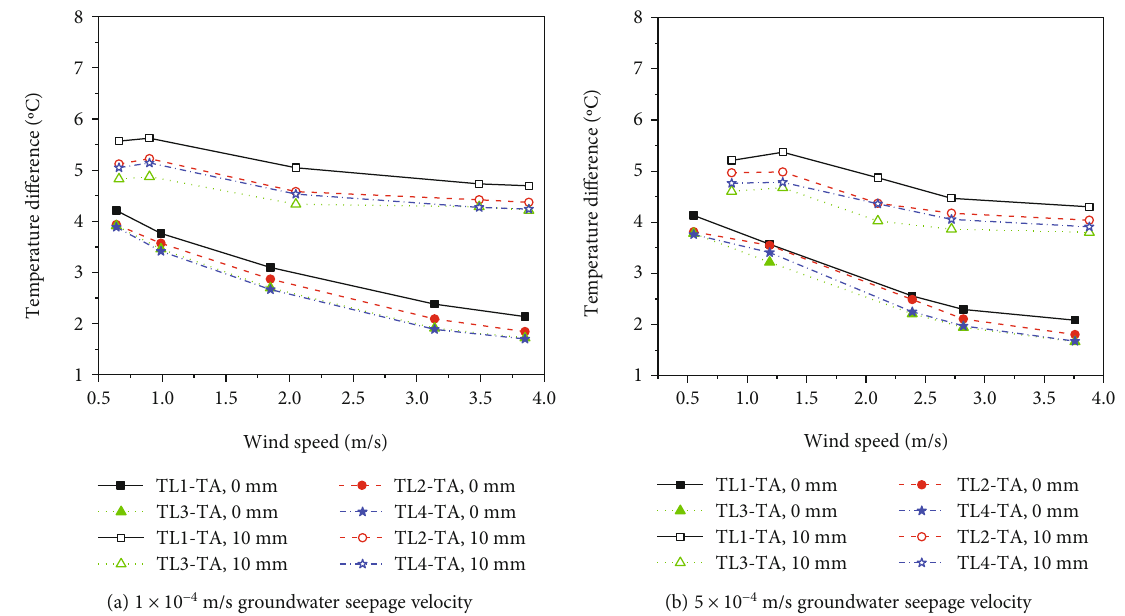
Figure 6: Impact of the insulation layer on the temperature di ff erence variation between tunnel lining and air fl